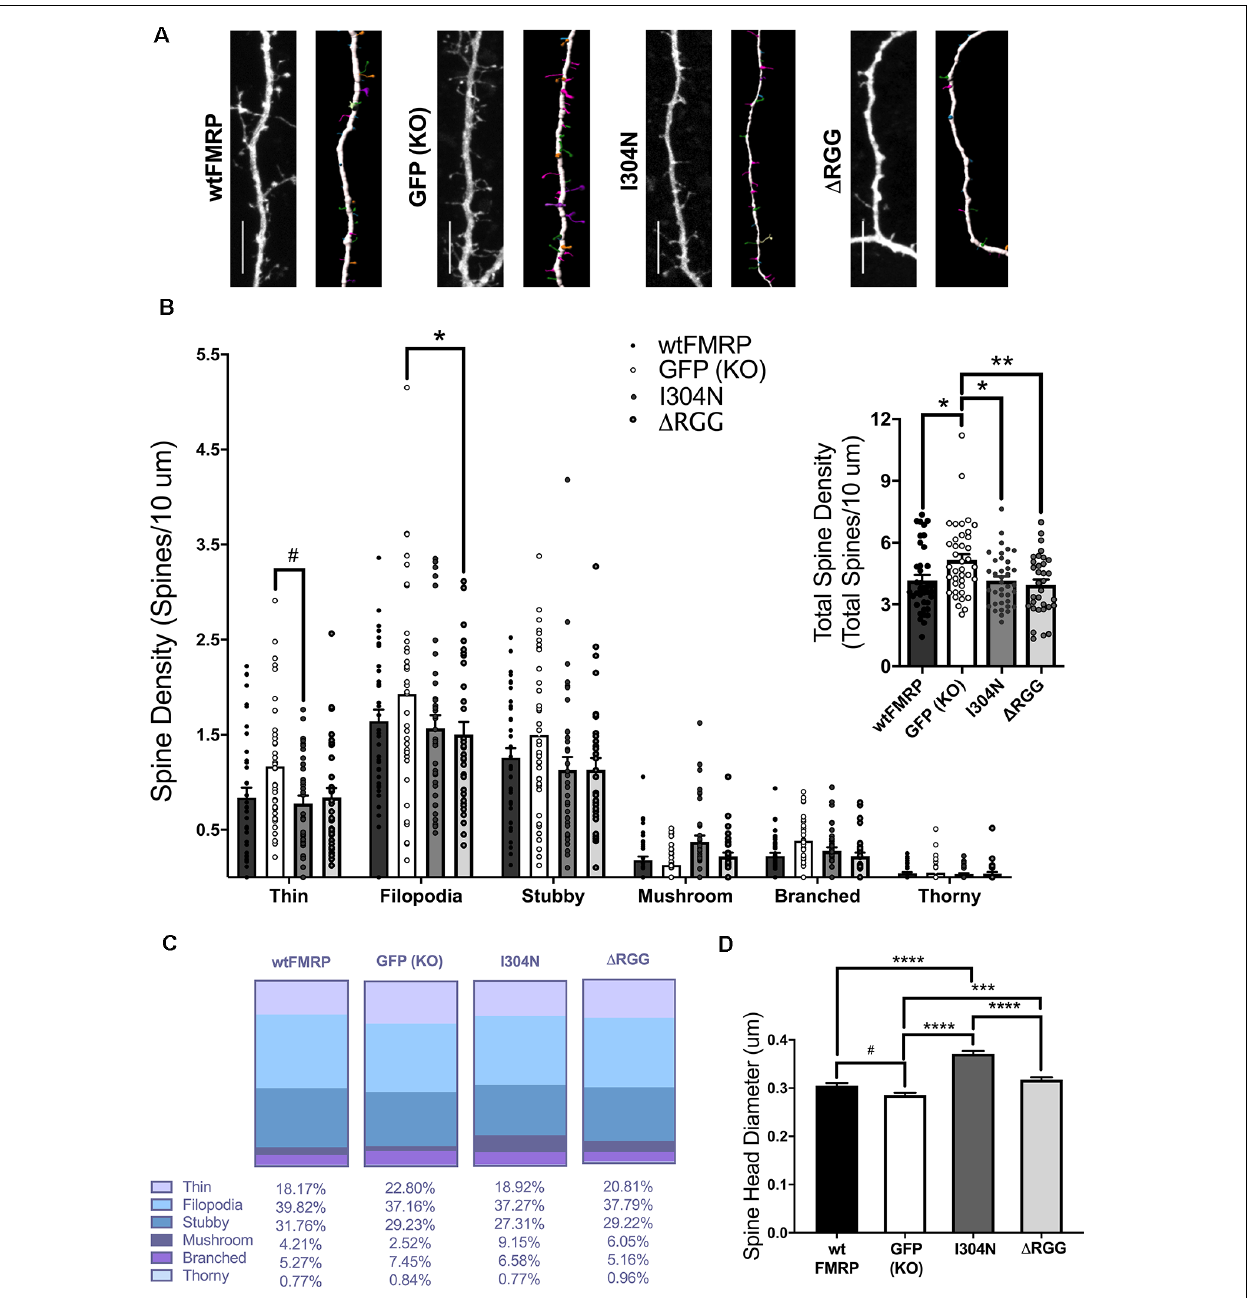
FIGURE 4 | Dendritic spine analysis of striatal MSNs at day in vitro (DIV) 14, following transfection with plasmids expressing mCherry and either wtFMRP-EGFP, GFP, I304N-FMRP-EGFP, or ∆ RGG-FMRP-EGFP ( A ; scale bars 10 µ m). Groups receiving either wtFMRP-or mutant FMRP-expressing plasmids had significantly decreased total spine density compared to the GFP ( Fmr1 KO) control group ( B ; one-way ANOVA). The ∆ RGG group had a significantly decreased density of filopodia spines, and the I304N group trended towards significantly decreased thin spines, compared to GFP (KO) control ( B ; two-way RM ANOVA). Relative distribution of spine types for each group is shown in panel (C) . Compared to the GFP (KO) group, spines in the I304N and ∆ RGG group had greater spine head diameter ( D ; one-way ANOVA). Bonferroni comparisons are indicated ( # p < 0.1, * p < 0.05, ** p < 0.01, *** p < 0.001, **** p < 0.0001); data shown are mean ±